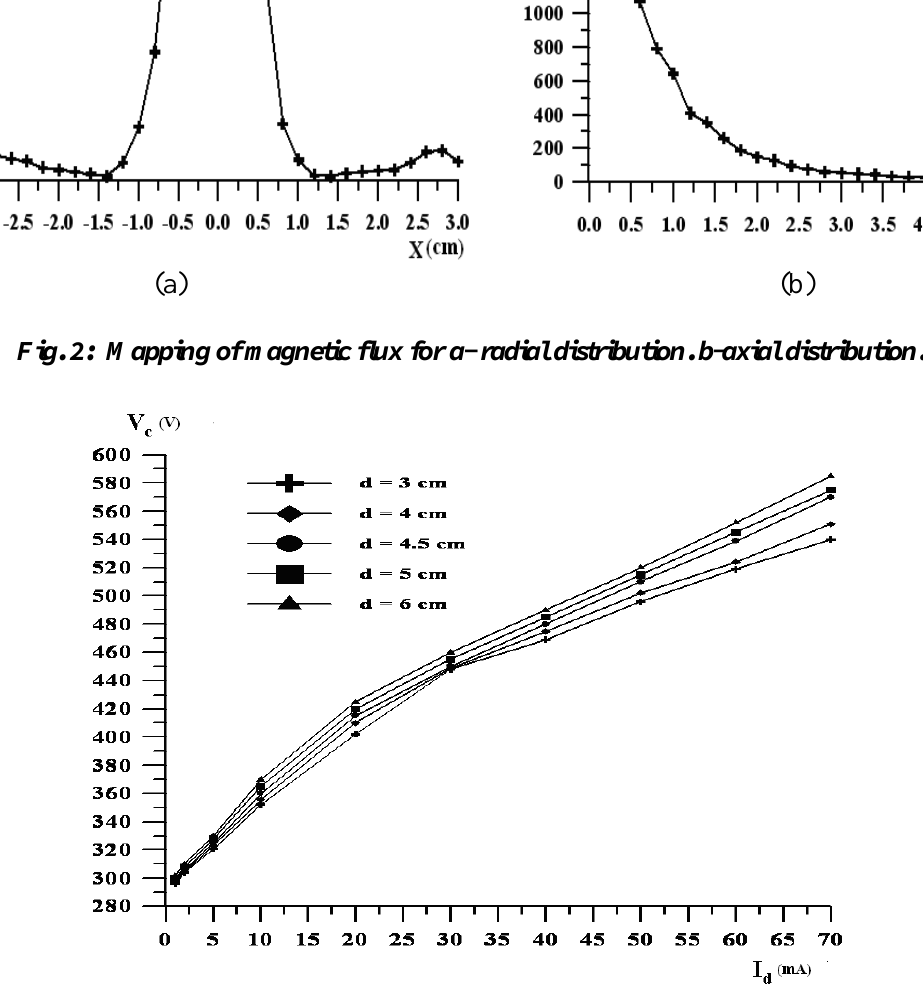
Fig.3: Cathode voltage as a function of sputtering current for different electrode separations at P=0.2